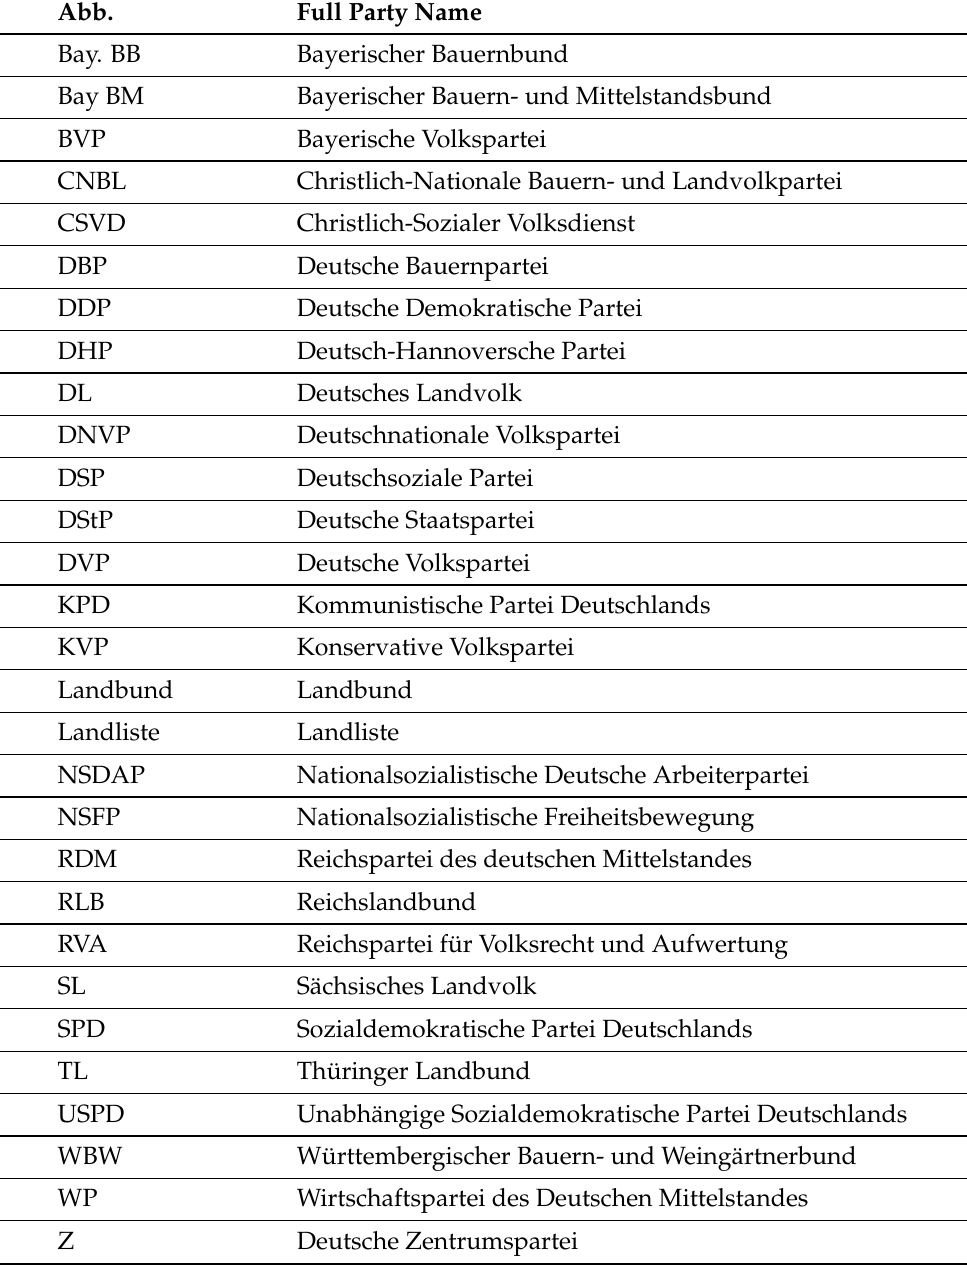
Table 8. Weimar Republic parliament, 1918–1932: abbreviations. Abb.